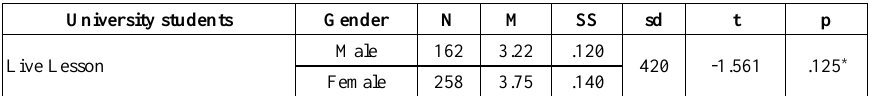
Table 7. Scores of university students’ live course situations according to